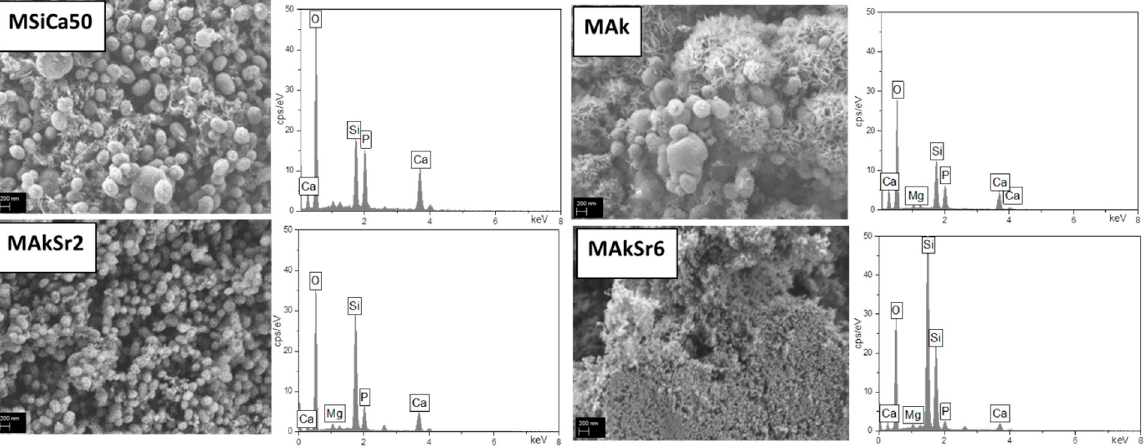
Figure 7. SEM micrographs (45.000× magnification, scale bar 200 nm) with EDX spectra of MSiCa50, MAk, MAkSr2 and MAkSr6 after 10 days in SBF.